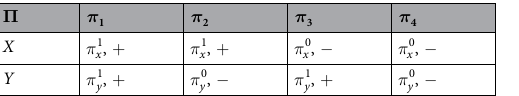
Table 1. Order patterns in two dimensional time series ( x ( t ), y ( t